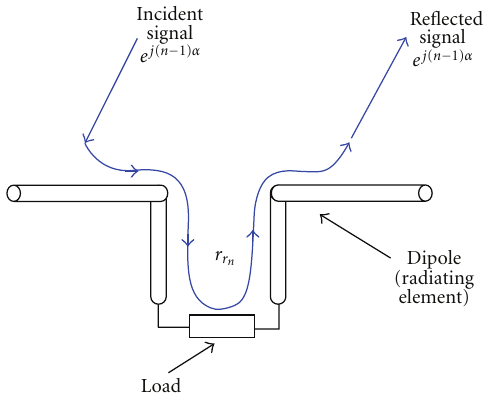
Figure 5: Signal reflection from the radiating element.